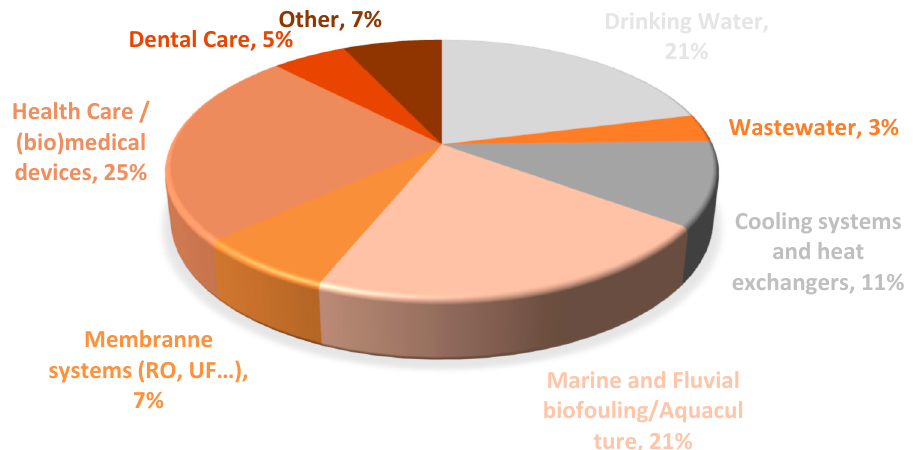
Figure 2. The main applications of copper surfaces according to the search obtained from SCOPUS database (29th September 2020) using the following keywords: “Copper” AND “Surfaces” AND “Biofilm” AND “Control”.